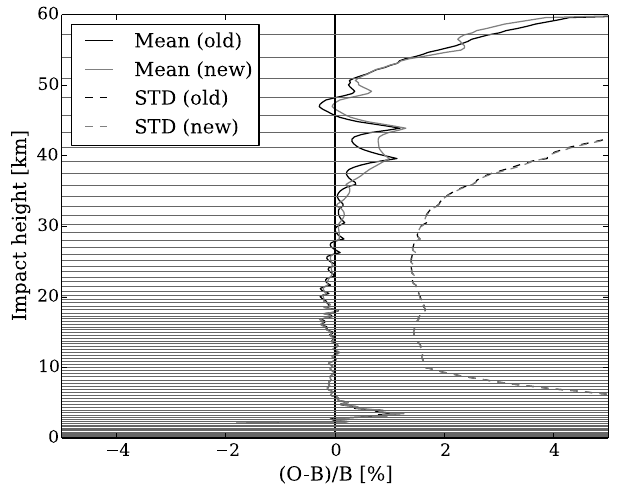
Figure 11. Bending angle innovation statistics as per Fig. 10, but with the background profiles thinned to half the vertical resolution of the 91-level ECMWF